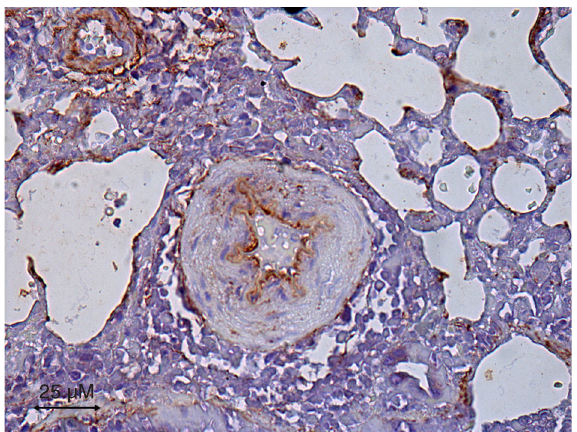
Figure 2. Photomicrograph of a lower right lobe with positive ex- pression of endothelial nitric oxide synthase on the endothelium and surrounding tissue of a small vessel. Magnification = 400X; Bar = 25 µM.